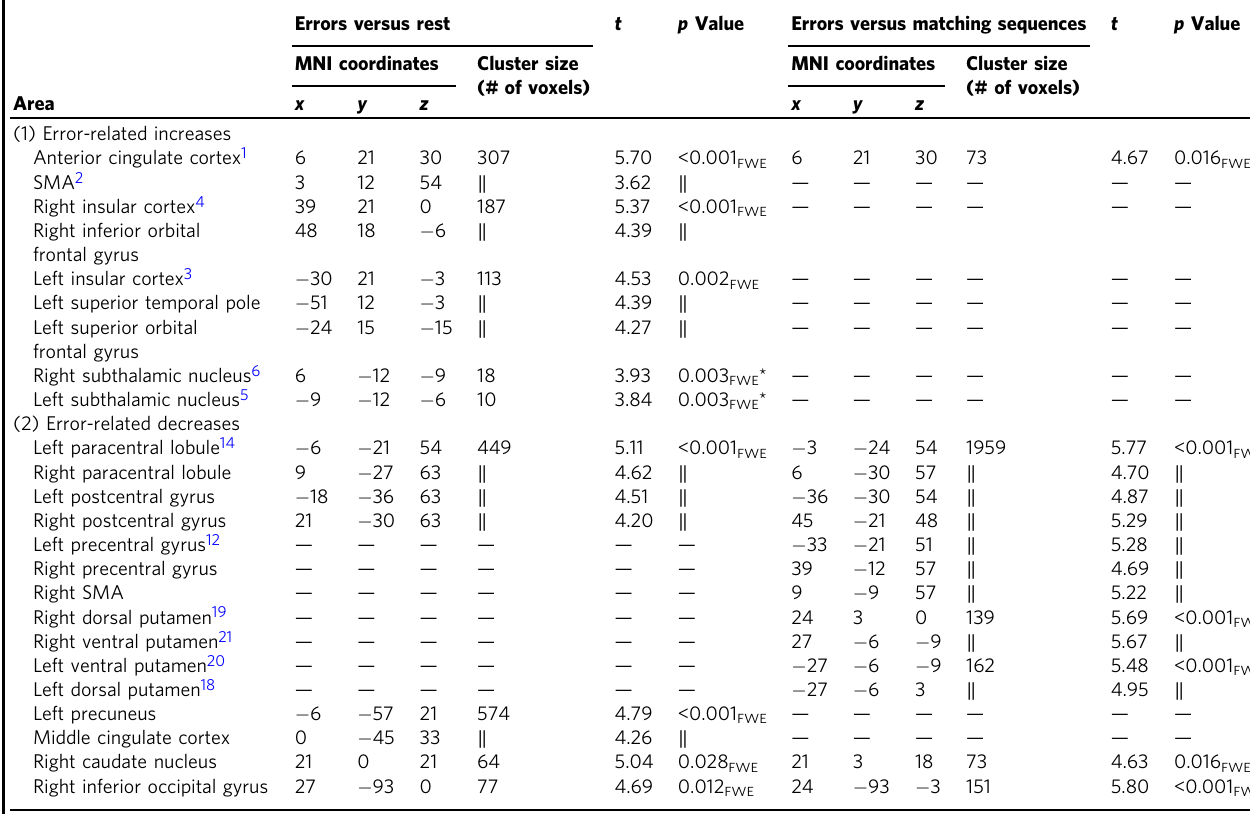
Table 1 Main effect of